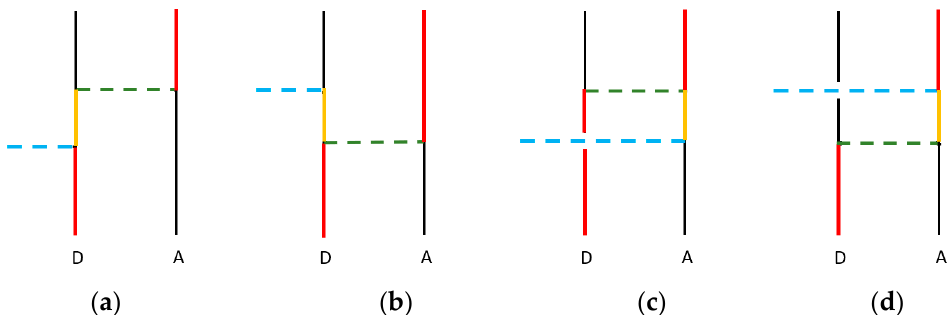
Figure 2. Near-zone graphs for calculating the matrix element for electronic energy transfer that linearly engages with a static electric field: in ( a , b ) the static field influences the donor decay transition; in ( c , d ) it affects the acceptor excitation. Red and black lines denote electronically excited and ground states, respectively; a yellow line denotes a virtual intermediate state. The blue dashed line indicates the applied static field, while the green dashed line denotes short-range dipole–dipole coupling.